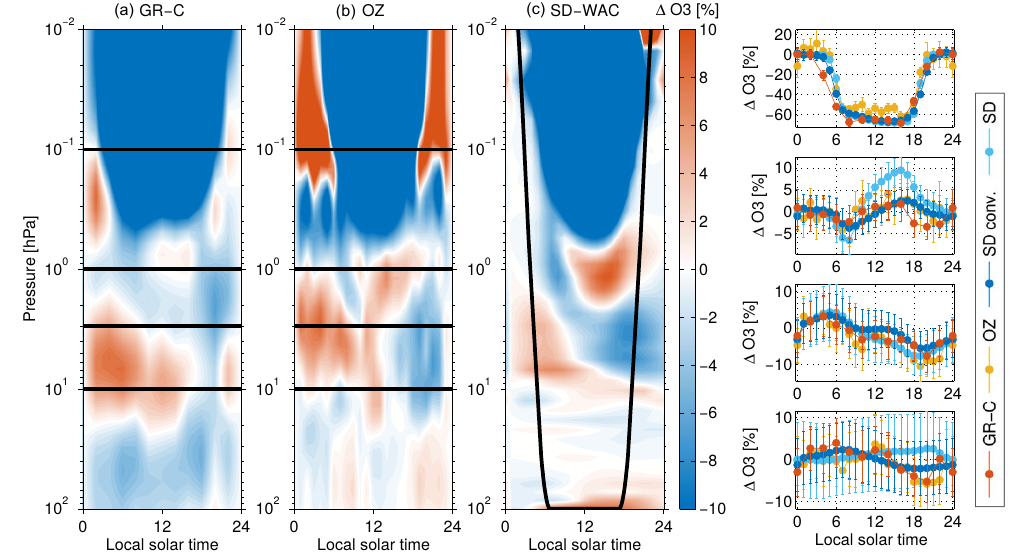
Figure 10. Same as in Fig. 9 but averaged over 10 days starting on 10 March 2016.